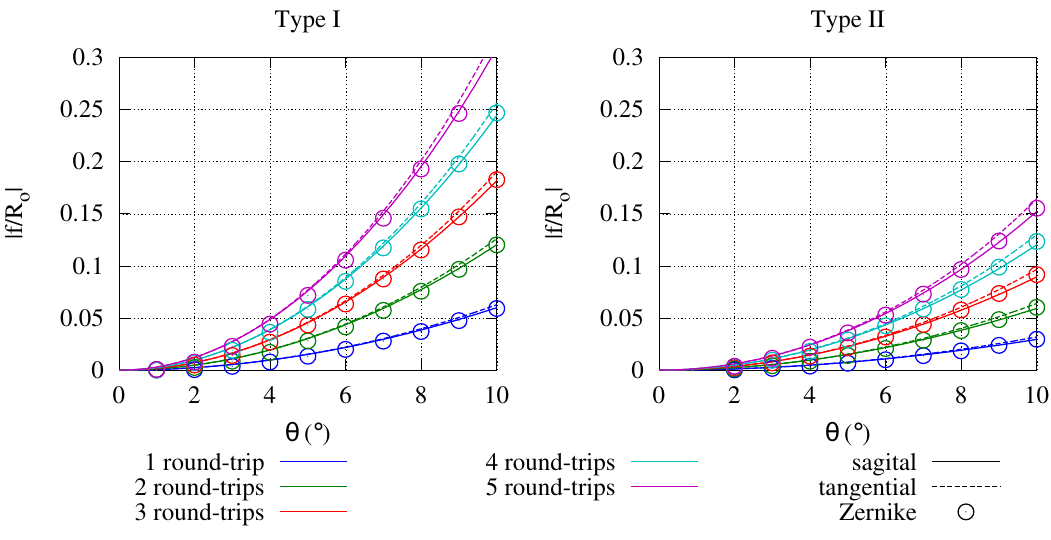
Figure 6. Absolute astigmatic deformation of the wavefront as a function of the incidence angle on optic L 1 for Type I and Type II systems. Lines are calculated by the matrix method, and single data points originate from FRED ray